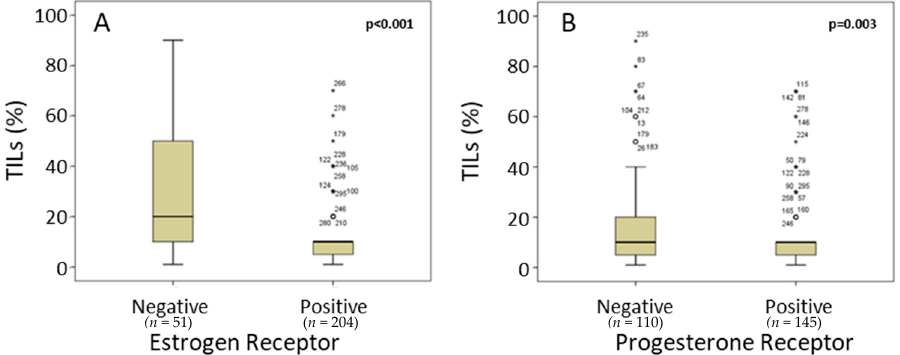
Figure 5. Level of TILs evaluated by the Salgado score is significantly higher in cases with no expression of ER α (compared with cases with ER α expression (( A ); p < 0.001). Level of TILs is also significantly higher in cases with no PR expression (( B ); p = 0.003). The numbers represent outliers, and the circles represent outlier cases. Extreme outliers are marked with an ( ★ ) on the boxplot. Significant correlations were also observed with type II nuclear receptors. Indeed,